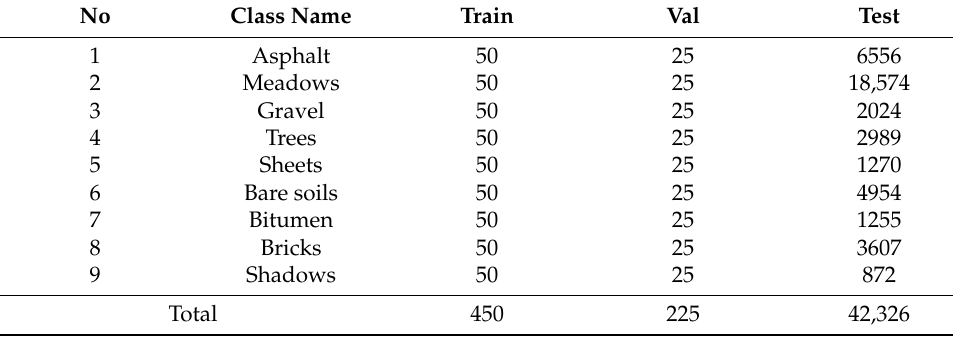
Table 4. The number of training, validation, and testing samples in the PU data